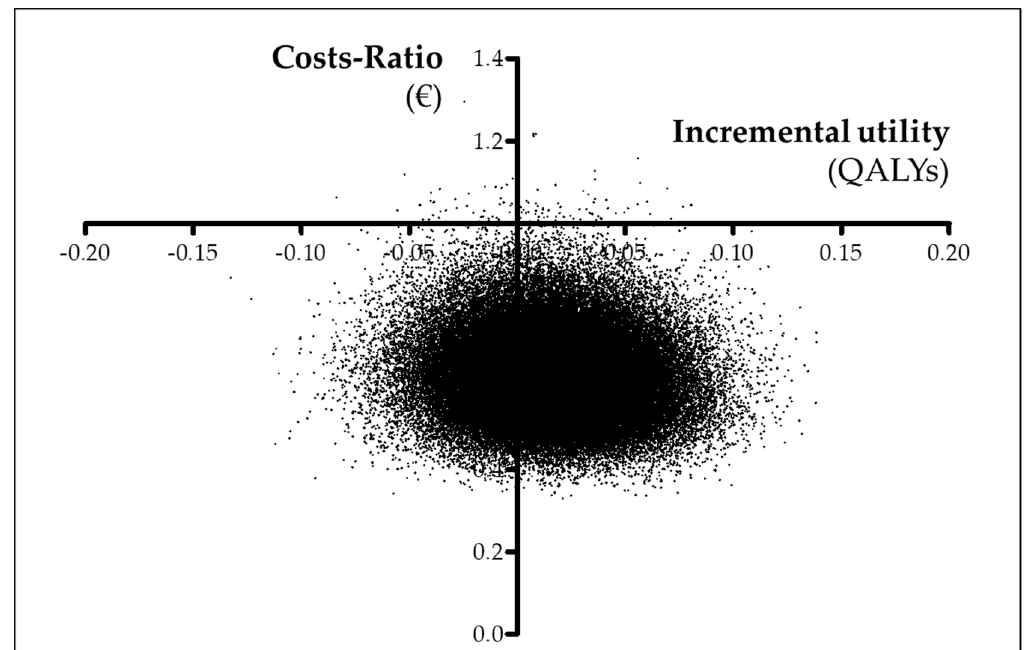
Figure 1. Cost-utility plane. Scatterplot showing the posterior costs ratio and incremental utility measured using QALYs.